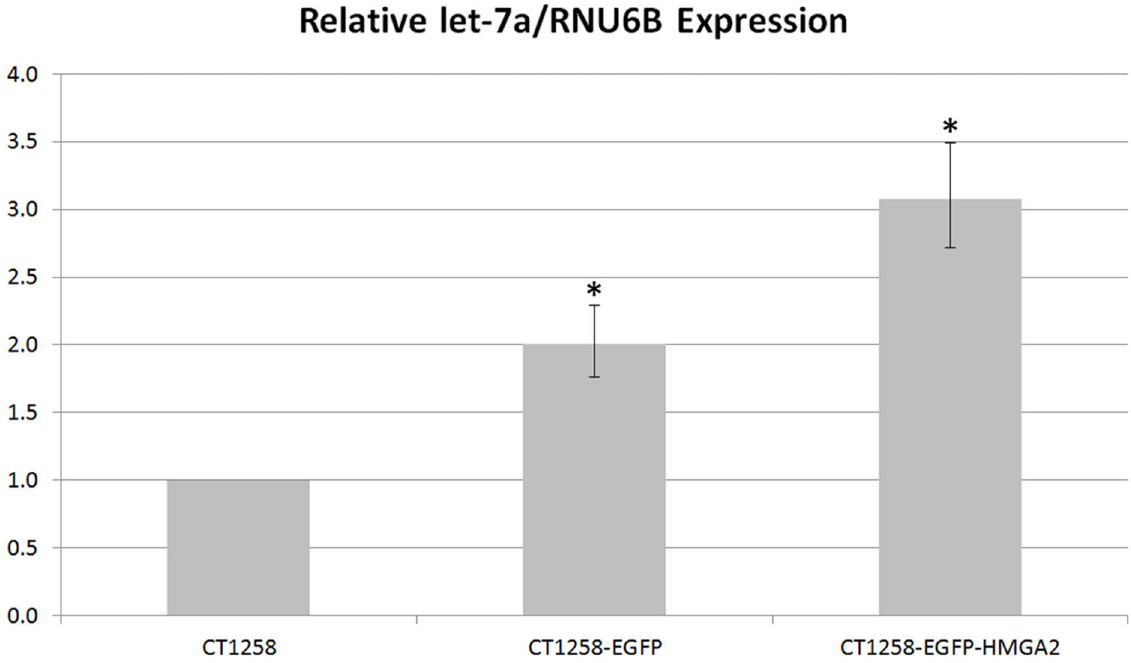
Figure 4. Let-7a real-time PCR analyses. Relative let-7a /RNU6B expression in native CT1258, CT1258-EGFP and CT1258-HMGA2-EGFP cells. Error bars are standard deviations. No statistical significant expression deregulation of let-7a in CT1258-EGFP and CT1258-HMGA2-EGFP was detected when compared to native CT1258 cells. Statistical significant p value was defined as # 0.05.